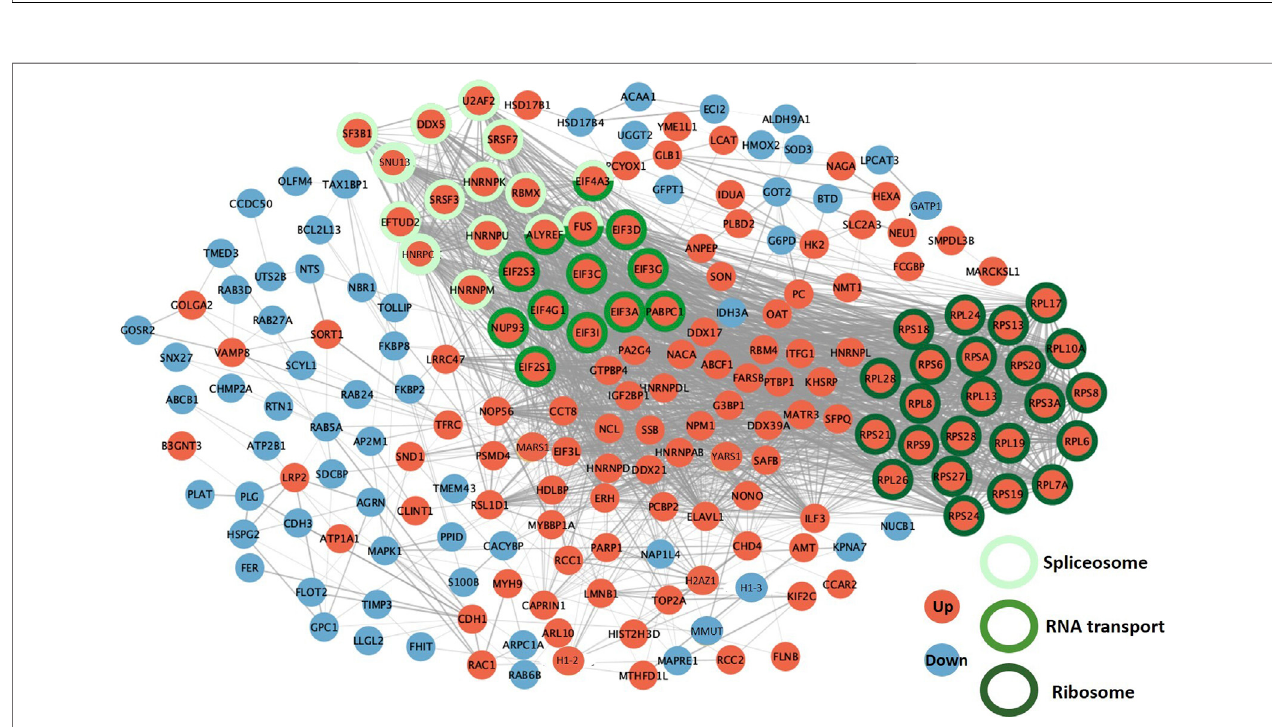
FIGURE 7 | Protein-protein interaction networks between differentially abundant proteins (DAPs) during the 8 – 12-cell-to-morula transition. The PPI network was built using STRING and Cytoscape. DAPs increased in abundance between the 8 – 12 cell and morula stages are in red while proteins decreased in abundance are in blue. The DAPs involved in the three most signi fi cant KEGG pathways are indicated by colored circles in green.